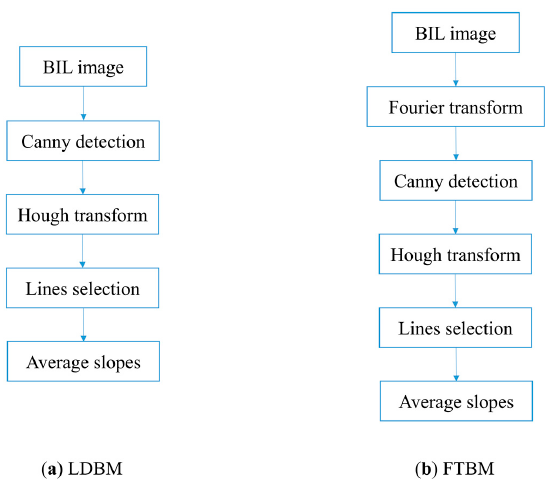
Figure 7. Flowcharts of ( a ) LDBM method and ( b ) FTBM method.